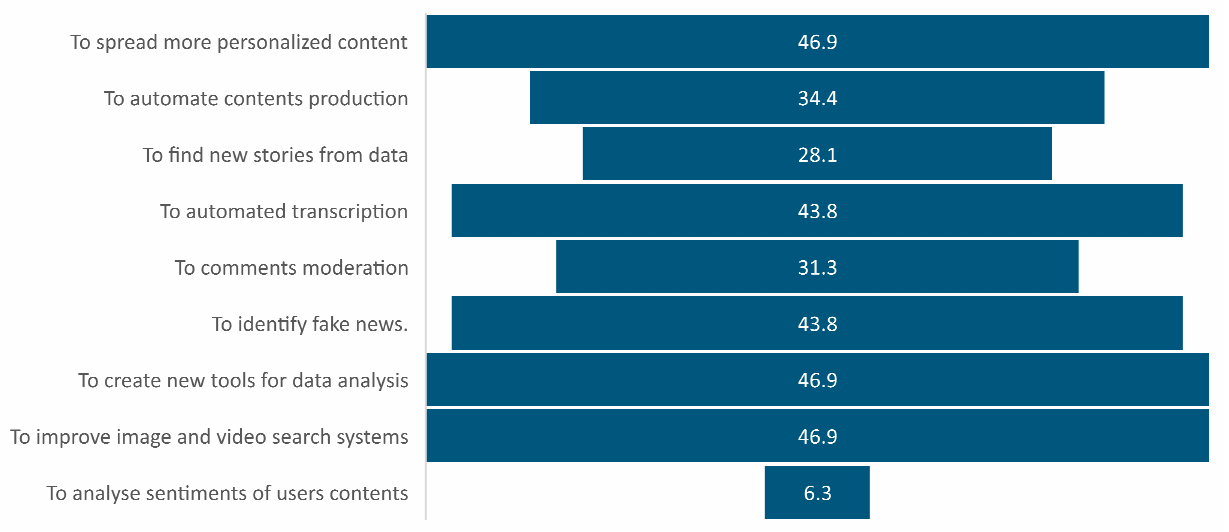
Figure 6. How AI can help journalistic work (scale 1 to 10).